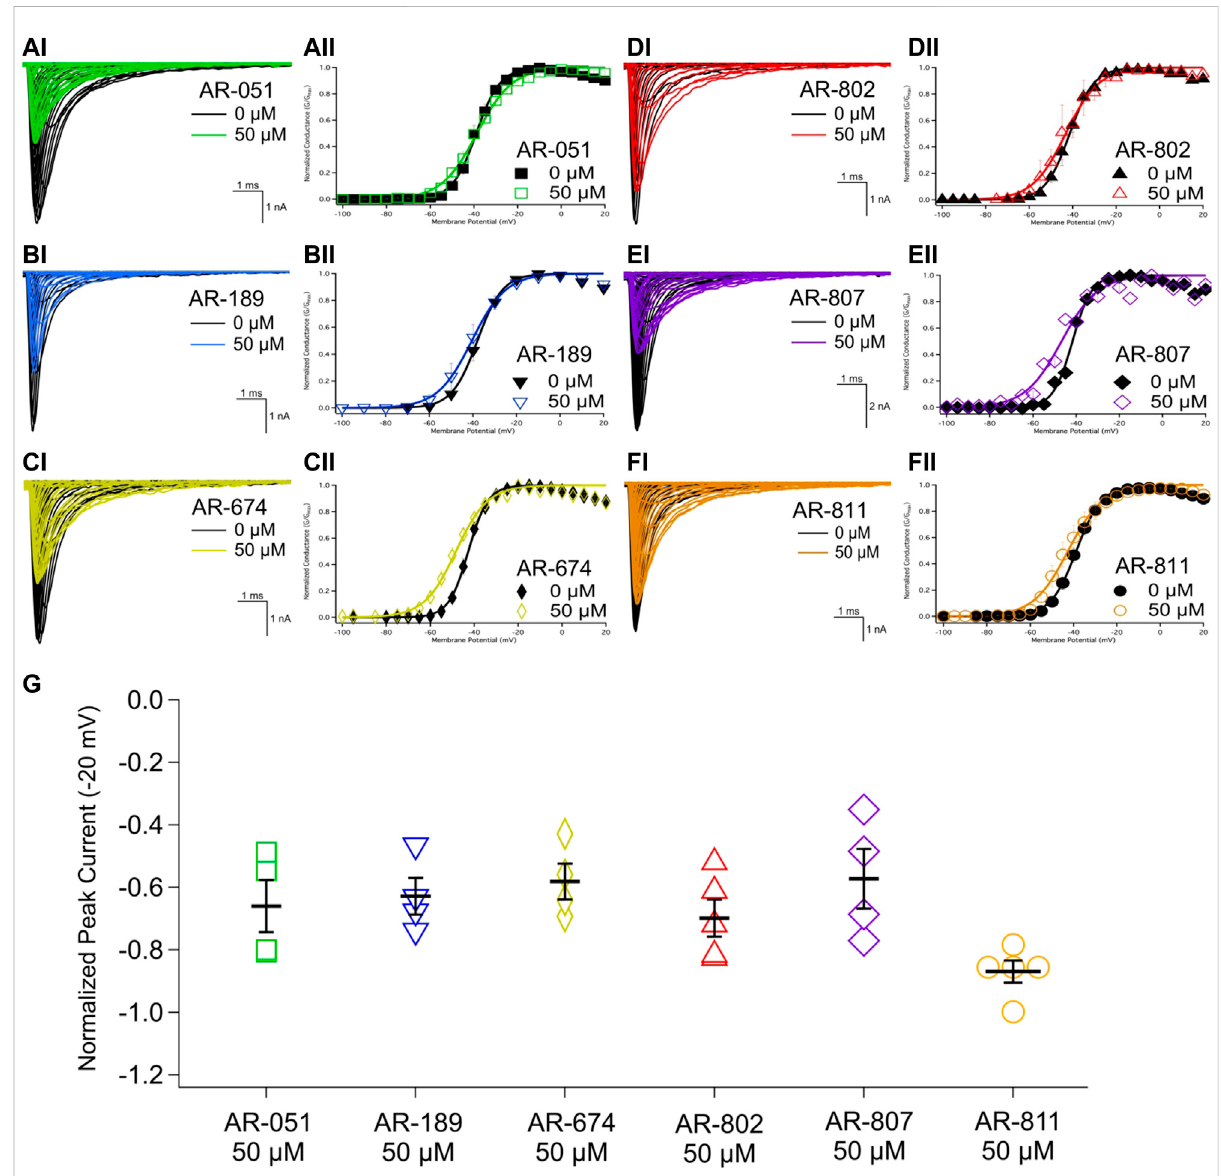
FIGURE 2 Peak I NA and conductance. (AI-FI) show representative traces of peak I Na in vehicle (black) and compound treatment at 50 µM (varied colors). (AII-FII) shows the voltage-dependence of conductance fi t with a Boltzmann curve for vehicle (black) and compound treatment at 50 µM (varied colors). (G) shows a box-plot for compound-induced shifts in normalized peak I Na (normalized to control) at − 20 mV. Statistical signi fi cance is reported in Table